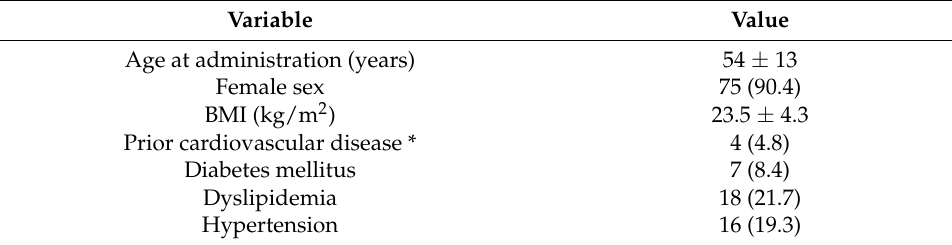
Figure 2. Flow of registration and follow-up. Table 2. Baseline characteristics of the study subjects ( n = 83).